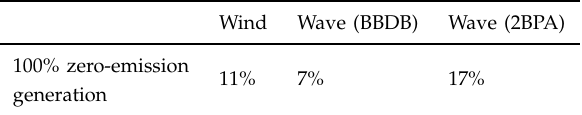
TABLE III P ERCENT REDUCTION IN REQUIRED BATTERY CAPACITY BY